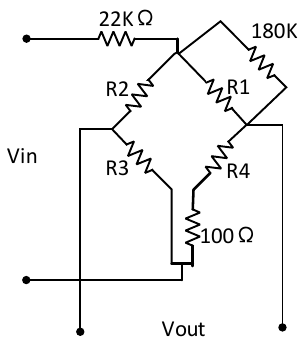
Figure 11. Passive resistor temperature compensation circuit using the data in Table 2.